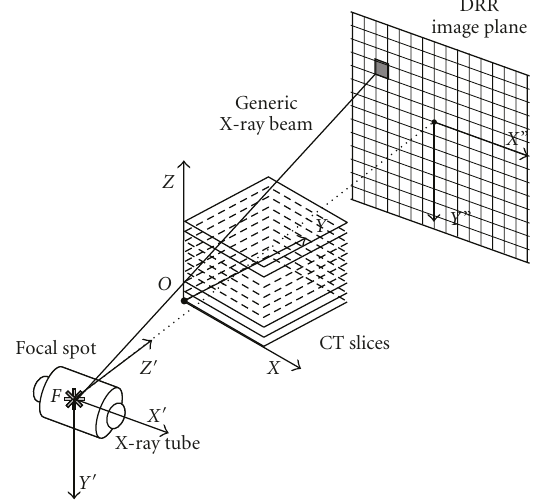
Figure 2: Algorithm for the simulation of the radiographic process. X-rays are modelled as straight lines (generic X-ray beam) through matter. The radiographic DDR image plane and X-rays are sampled. X-ray attenuation values of the CT 3D model are integrated together with a generic ray in order to obtain the grey-level of the corresponding pixel of the DRR.